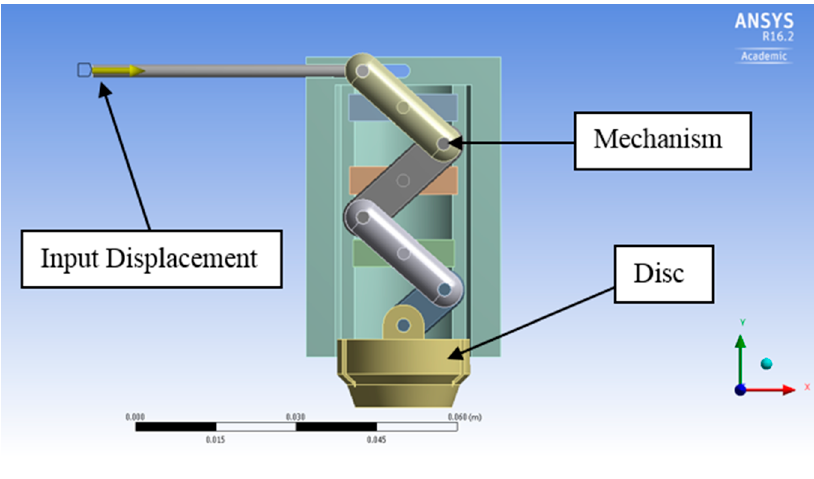
Figure 4. Simulation model for position analysis.